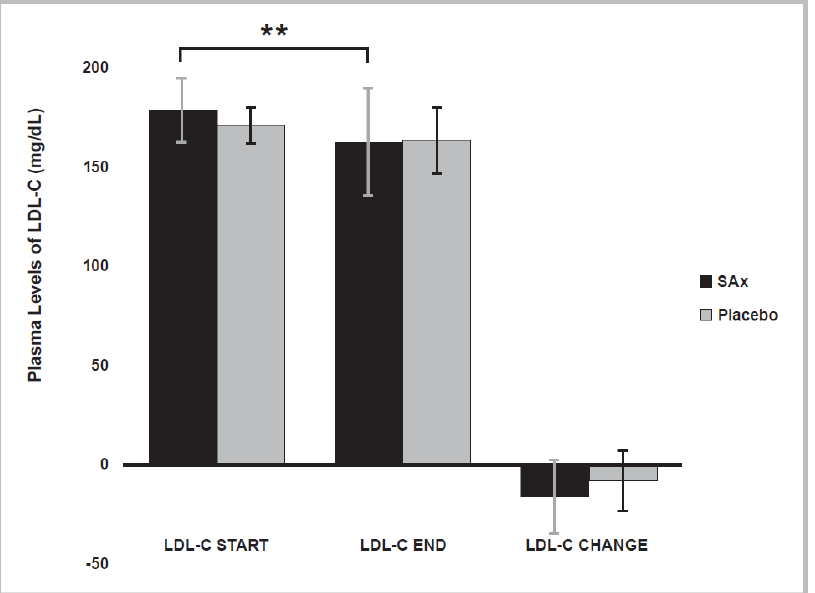
Figure 2. The plasma levels of low-density lipoprotein cholesterol (LDL-C) significantly decreased after SAx treatment (oral supplementation with hydroxytyrosol (HT) and punicalagin (PC)) (black color) in subjects with high plasma levels of LDL-C, a risk factor for CVD, ( n = 16) (** p < 0.01). This effect was not observed after placebo treatment (gray color). The data represent the adjusted means ± standard deviations (SDs) from multivariate models.